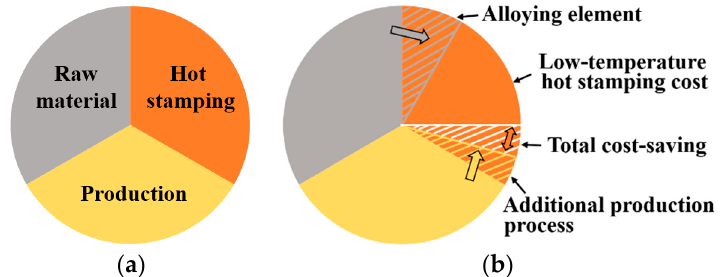
Figure 11. Schematic of estimated cost breakdown for ( a ) conventional Mn-B steel; ( b ) MMn steel.